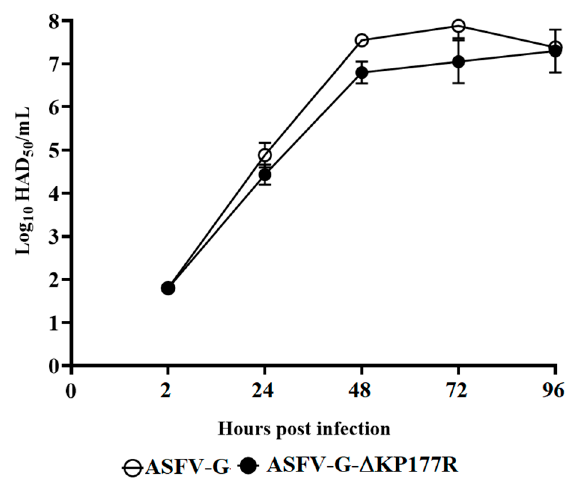
Figure 3. In vitro growth kinetics in primary swine macrophage cell cultures for ASFV-G-∆ KP177R and parental ASFV-G (MOI = 0.01). Samples were taken from three independent experiments at the indicated time points and titrated. Data represent means and standard deviations.